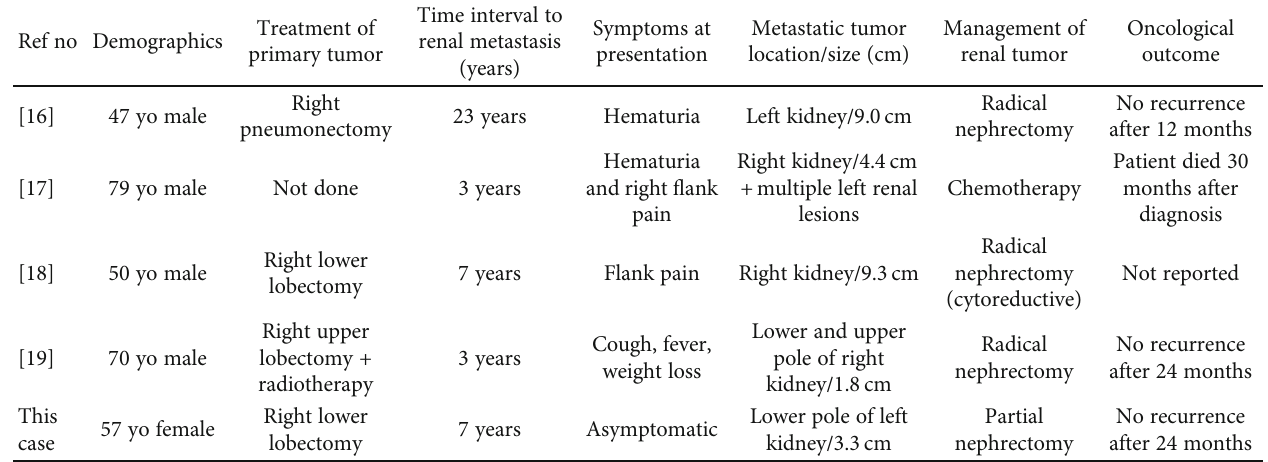
Table 1: Summary of primary lung ACC cases with renal